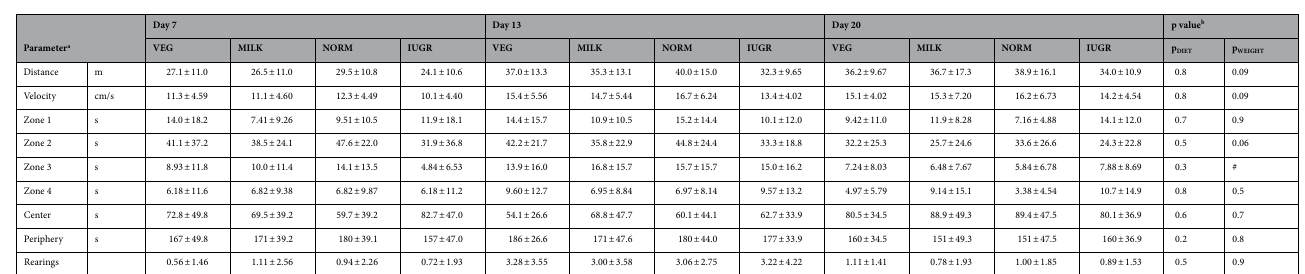
Table 2. Open field parameters on day 7, 13 and 20. Data are pooled and presented as main effects of diet and birth weight (n = 18). Data are shown as mean ± SD. All data were analysed using a linear mixed model and p < 0.05 is considered statistically significant. VEG vegetable oil, MILK bovine milk fat, NBW normal birth weight, IUGR intrauterine growth restricted. # A weight × day interaction for time spent in zone 3 of the arena is present (day 7: p < 0.01, day 13: p = 0.8, day 20: p = 0.6). a Supplementary Fig. S1 defines each zone of the open field arena. b The overall p value indicating differences between either dietary or weight groups over